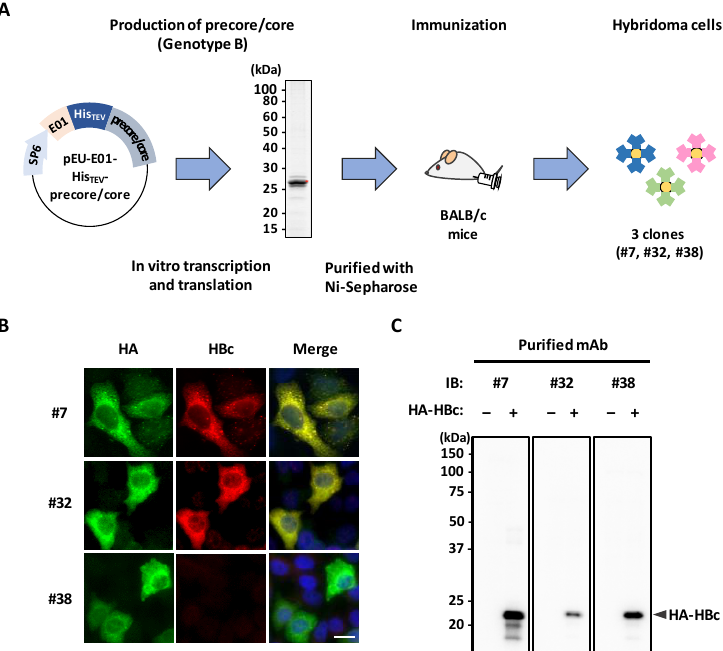
Figure 1. Production and screening of anti-HBc mouse mAbs. ( A ) Schematic of the generation of hybridoma cells that produce anti-HBc mouse mAbs. Recombinant His-precore/core (derived from HBV genotype B) was synthesized by a wheat germ cell-free system and purified with Ni-Sepharose. The red dot indicates the target protein. The purified protein was injected into BALB/c mice. Four weeks later, isolated lymphocytes were fused with myeloma cells, and hybridoma clones were established. SP6, SP6 promoter sequence; E01, translation enhancer sequence; His, histidine-tagged sequence; TEV, TEV protease-recognized sequence. ( B , C ) The reactivity of three mAbs (#7, #32, and #38) for HBc. HepG2 cells transfected with HA-HBc were fixed with 4% PFA and stained with the indicated mAbs (hybridoma supernatants, red; HA-antibody, green) and DAPI (blue). Scale bar, 10 μ m ( B ). HepG2 cell lysates transfected with HA-HBc were analyzed by immunoblotting with the indicated mAbs ( C ).